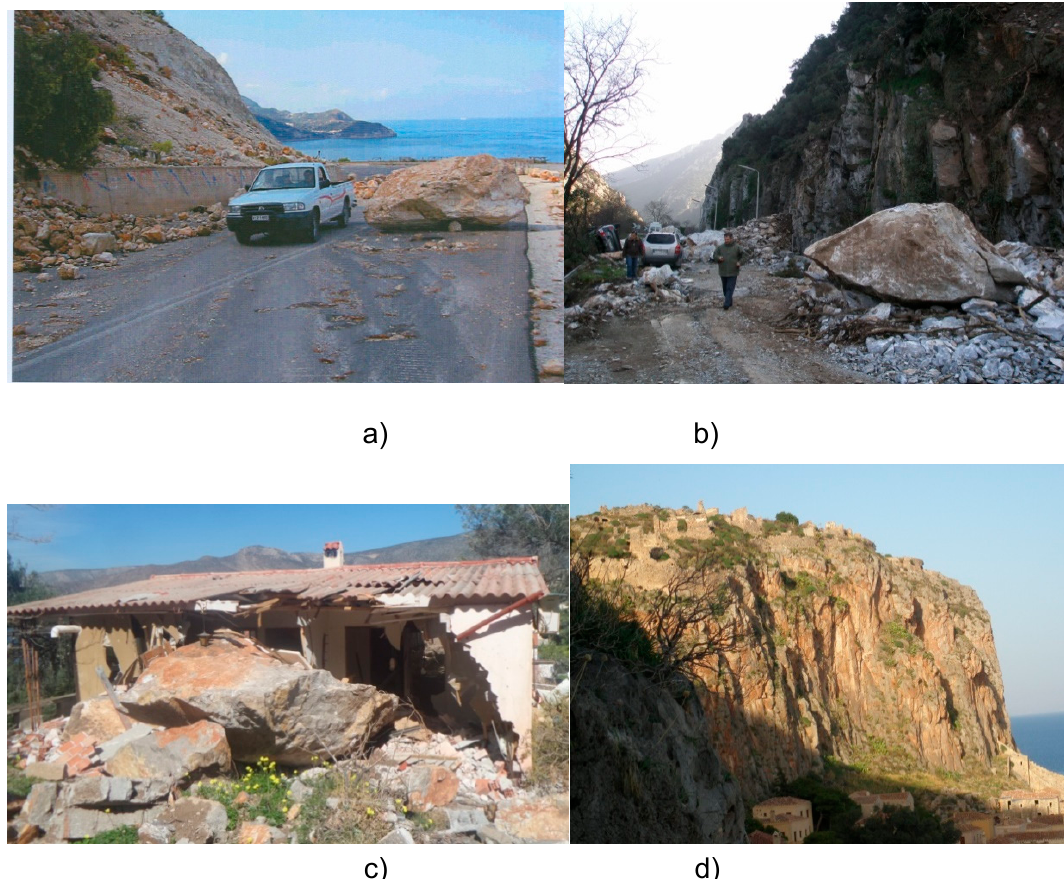
Figure 5. Impact of main rockfall events: ( a ) on local road network in Lefkada during 2003 earthquake (site 3) ( b ) on National Highway in Tempi valley in 2009 (site 11), ( c ) in Alyki village in 2019 (site 43), ( d ) in Monemvasia archaeological site (site 19).